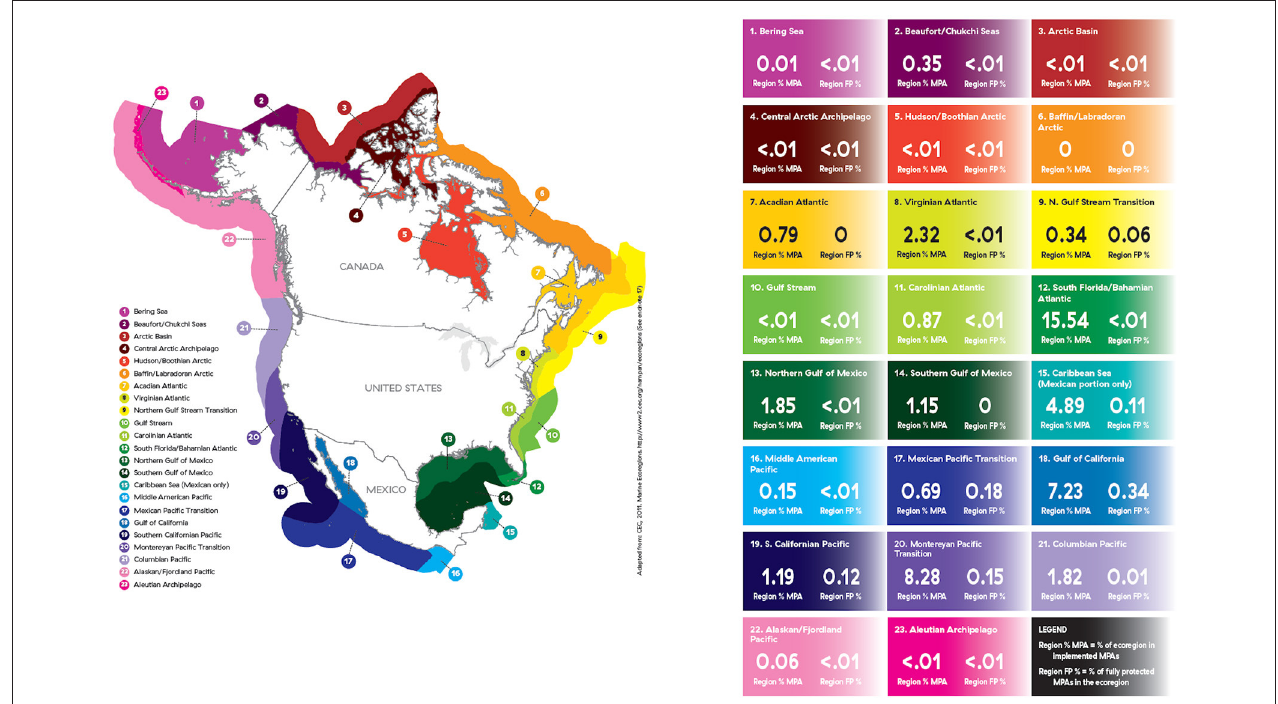
FIGURE 2 | Percentage of each CEC ecoregion in the North American continental ocean estate that contains implemented MPAs (% MPA) and fully protected MPAs (% FP; adapted from: CEC, 2011).